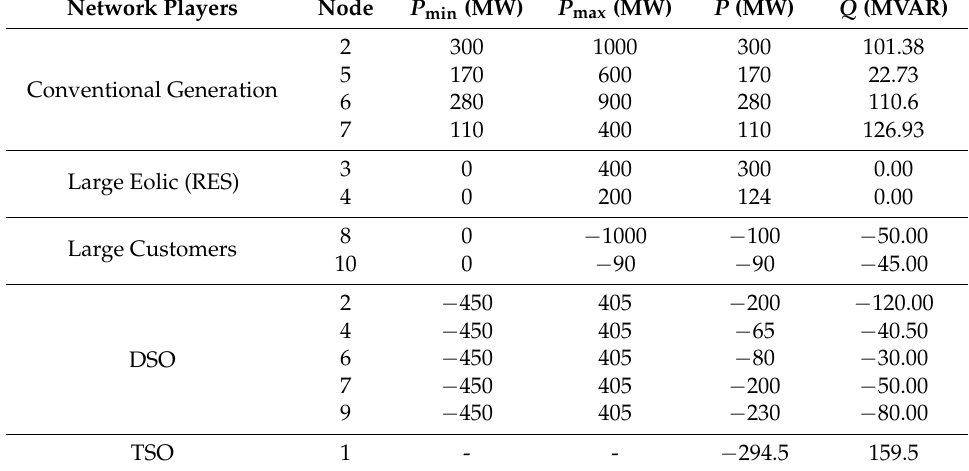
Table 2. Generation and load characteristics.